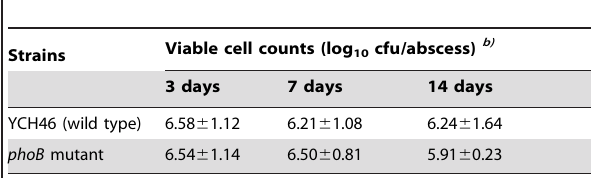
Table 4. Viable B. fragilis cell numbers in the peritoneal abscesses a